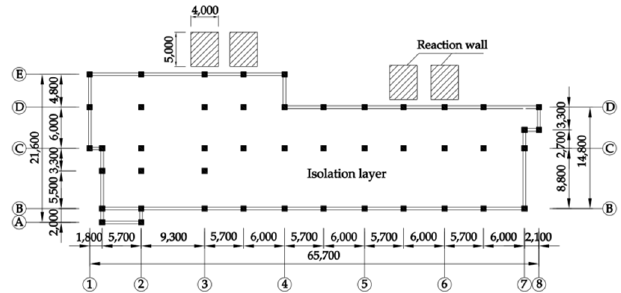
Figure 11. Reaction wall layout plan (unit: mm).